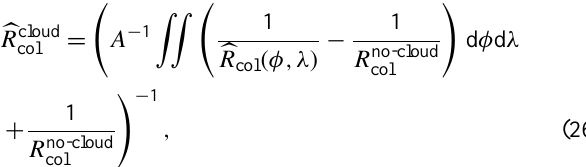
Figure 4. Horizontal-size dependence of b R cloud ent types of clouds: cumulus and stratocumulus (1–2km, red), alto- stratus (3–5km, green), altocumulus (2–3km, blue), nimbostratus (2–5km, yellow), and cirrus (8–9.5km,